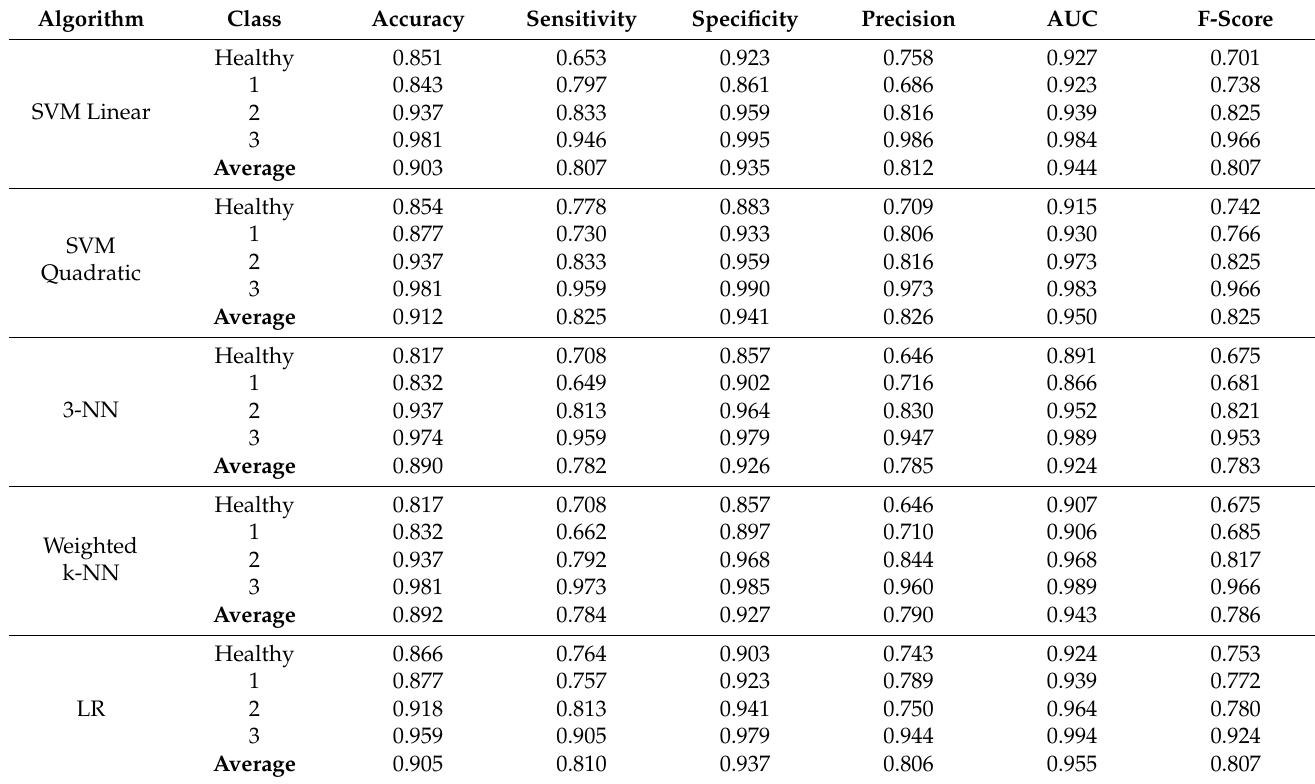
Table 3. Metrics scores for Model 1, with 4